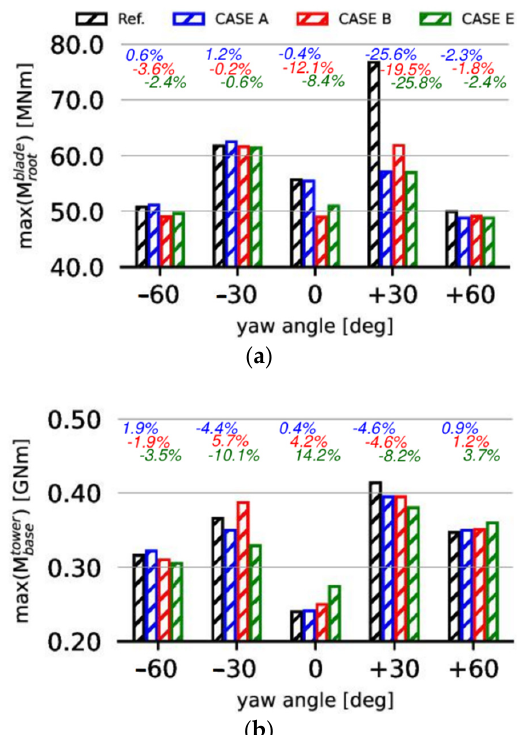
Figure 15. DLC-6.x ultimate loads vs. yaw angle of examined configurations (including safety factors) maximum combined bending moment ( a ) at the blade root and ( b ) at the tower base.